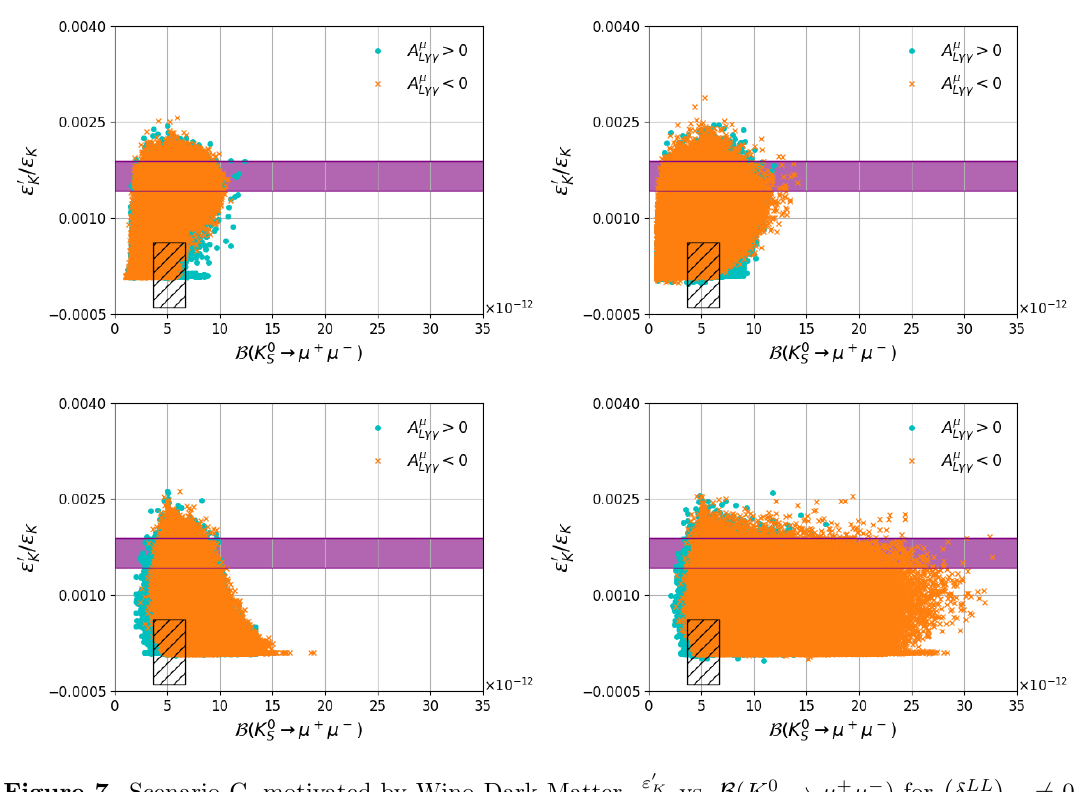
Figure 7 . Scenario C, motivated by Wino Dark Matter, " and ( M 3 (cid:1) (cid:22) ) > 0 (upper left), ( M 3 (cid:1) (cid:22) ) > 0 (lower left), and to A (cid:22) > 0 and the orange crosses to A (cid:22) L(cid:13)(cid:13) experimental results and the hatched area to the SM prediction.